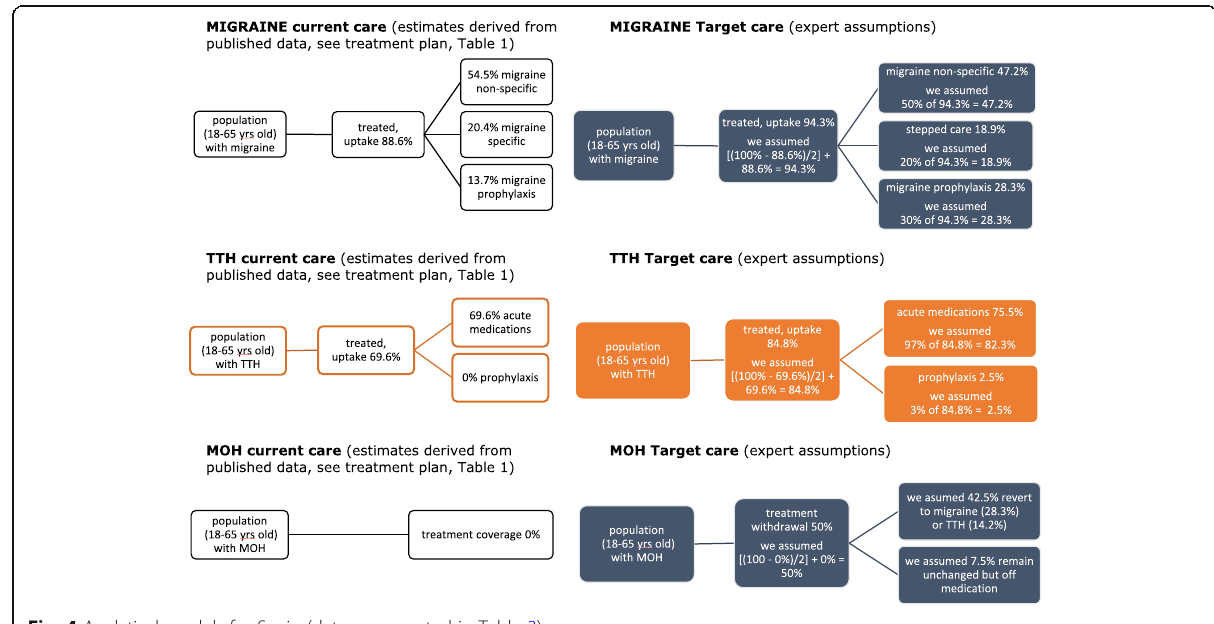
Fig. 4 Analytical models for Spain (data are reported in Table